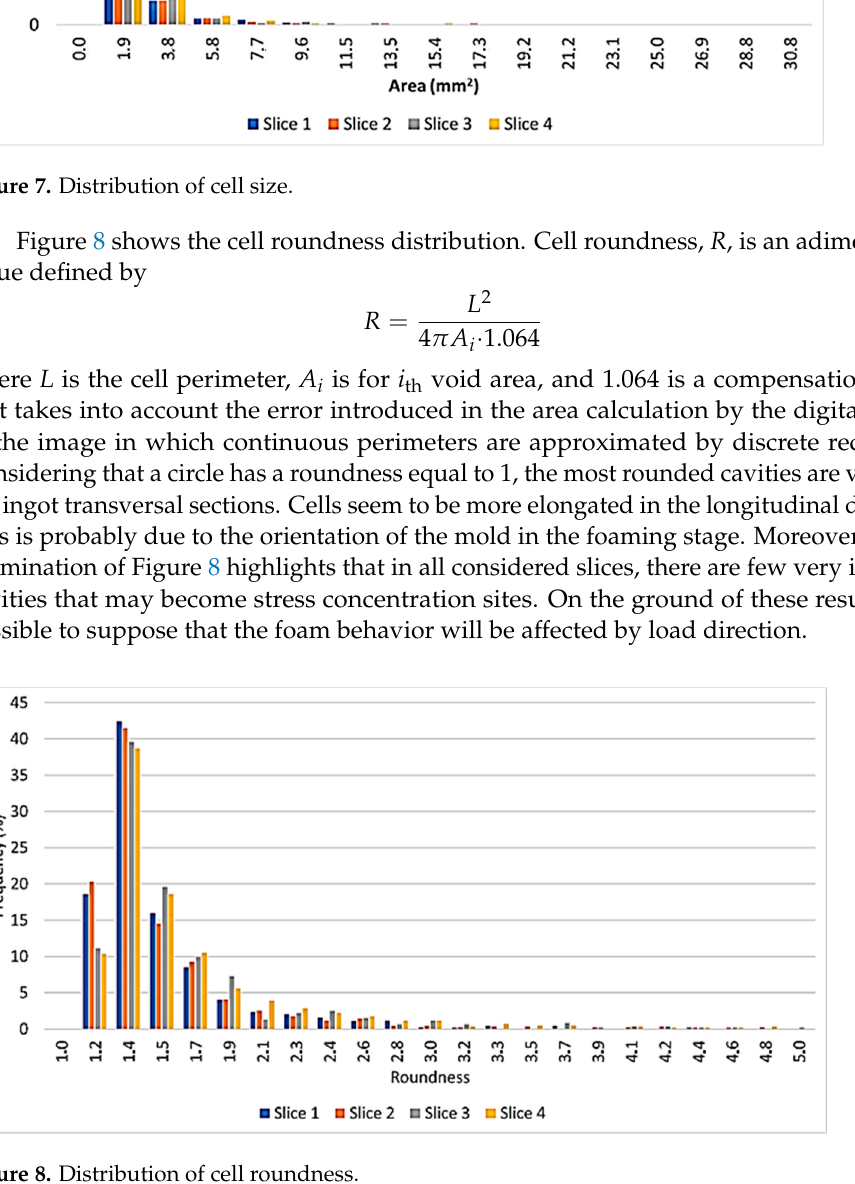
Figure 8. Distribution of cell